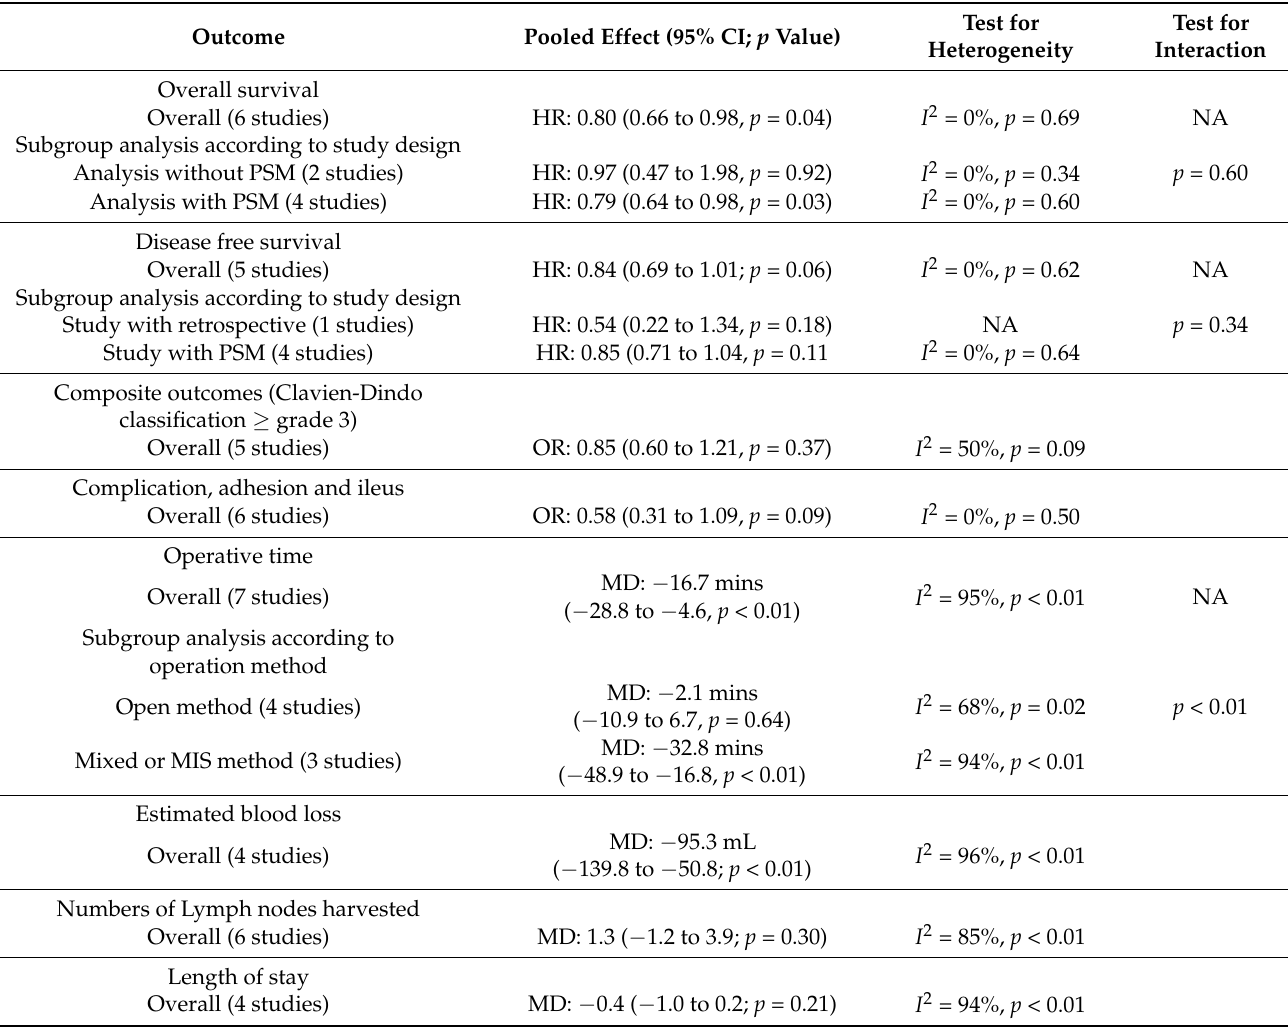
Table 3. Summary measures of primary and secondary outcomes for partial omentectomy versus total omentectomy in gastric cancer patients with subgroup